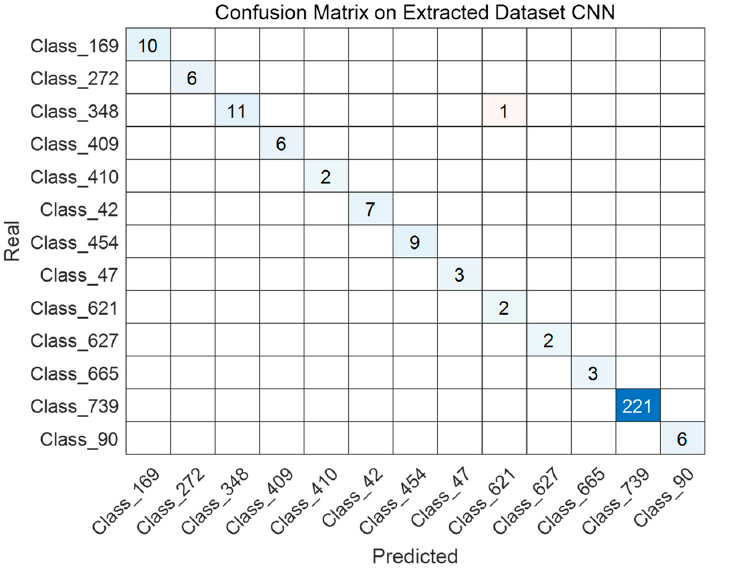
Figure 14. Confusion matrix of the validation dataset. The four classes containing the largest number of pulses, Class_739, Class_348, Class_454, and Class_169, were selected for analysis, and their carrier frequencies, pulse widths, amplitudes, and PRIs are shown in Figure 15.